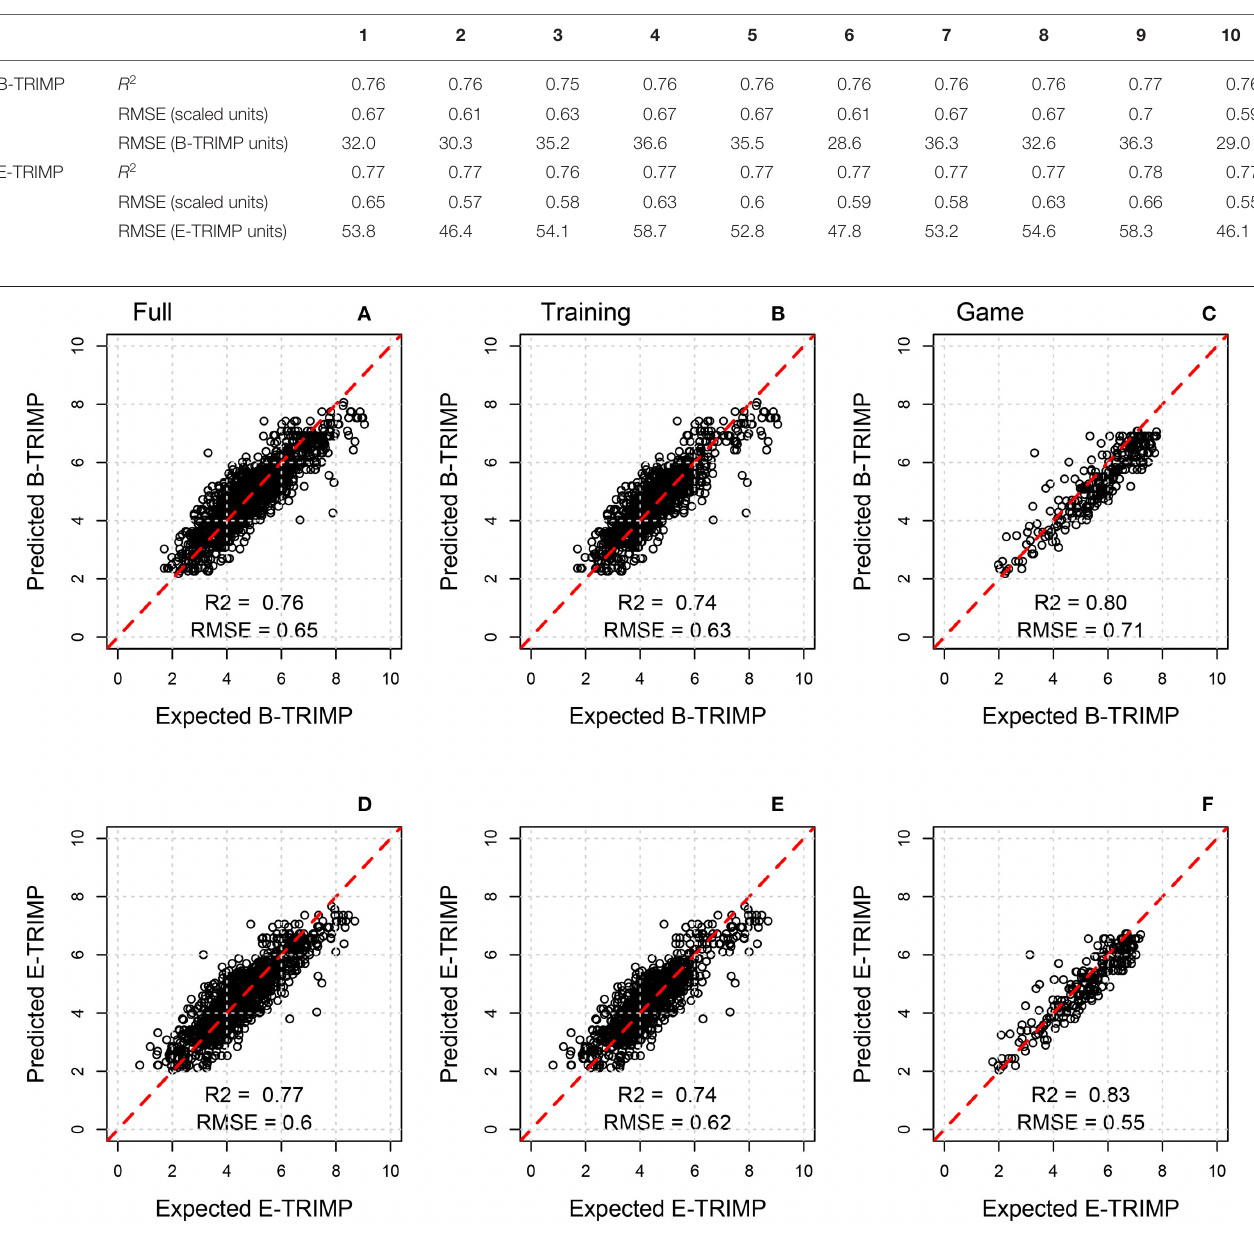
FIGURE 2 | Predicted vs. Expected values for B-TRIMP and E-TRIMP using the final prediction models. Data are presented as a full dataset (A,D) , a training dataset (B,E) , and game dataset (C,F) . Coefficient of determination ( R 2 ), and root mean square error (RMSE).